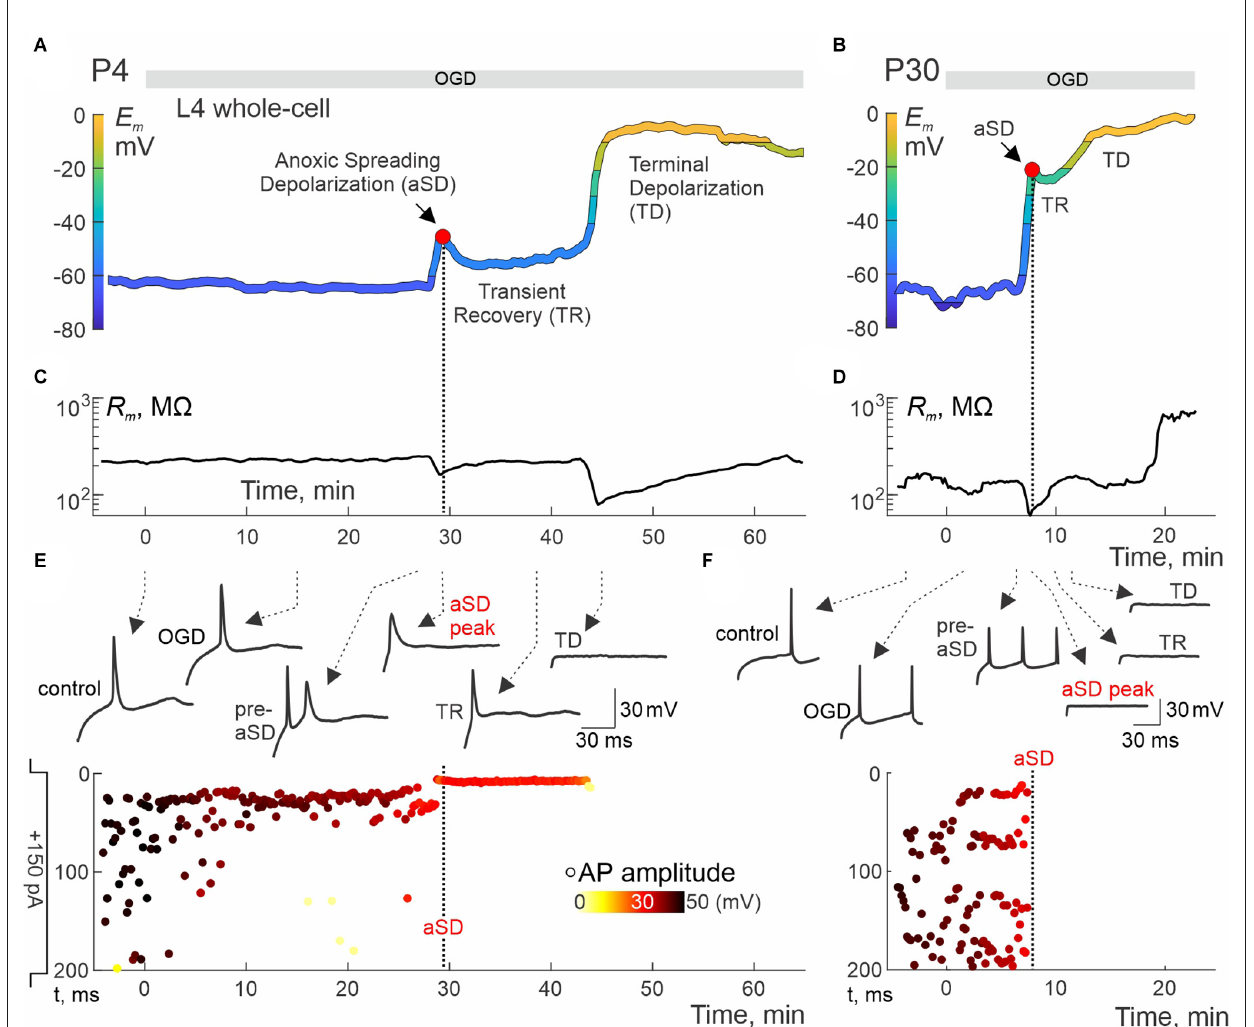
FIGURE2 Immature neurons remain excitable during aSD and transient recovery phase. (A,B) Examples of E m recordings from L4 neurons in slices from P4 (A) and P30 (B) rats. E m traces are low-pass filtered and color-coded as in Figure 1 . The exposure to OGD is indicated by the horizontal gray bar at the top. (C,D) Corresponding changes in input resistance ( R m ). (E,F) Corresponding example responses to suprathreshold current steps at different time points indicated by arrows (top traces) and raster plots of APs evoked by suprathreshold (+150 pA, 200 ms) current steps (y-axis shows depolarizing step time (top: step start; bottom: step end); APs amplitude is color-coded) (bottom plots). Full trace examples are shown in Supplementary Figure 1 . Note that the AP firing is maintained through the aSD and TR, and disappears only during the transition to TD in the P4 neuron, whereas in